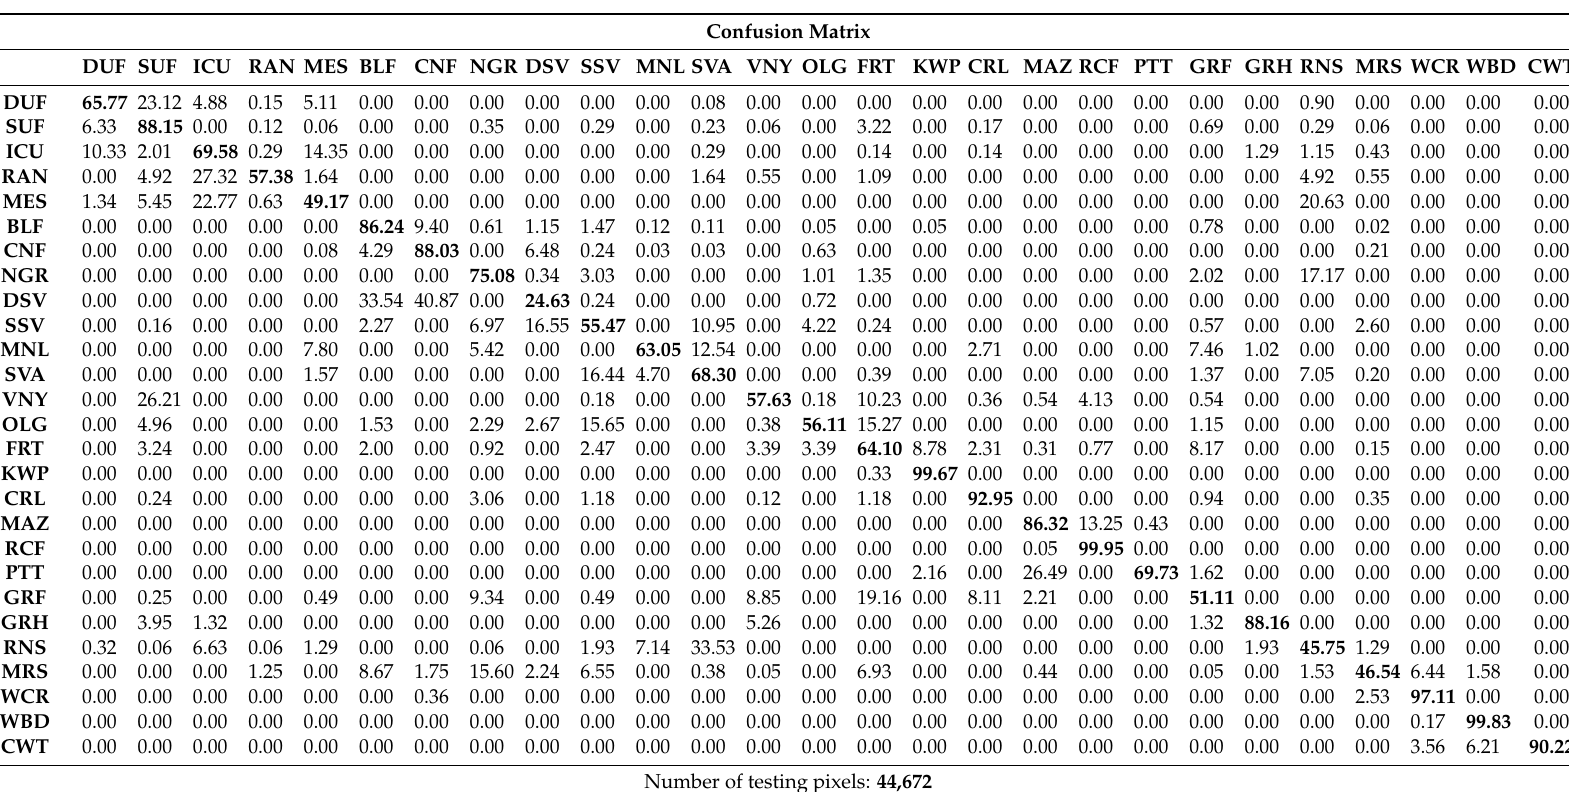
Table 7. The confusion matrix for the SVM classification framework (Dataset #2 on the top 70% of features). Columns represent classification labels and rows represent the testing data labels. Values are given in percentage (%) of testing pixels (normalised per row). Diagonal values express the PA for each class. Confusion